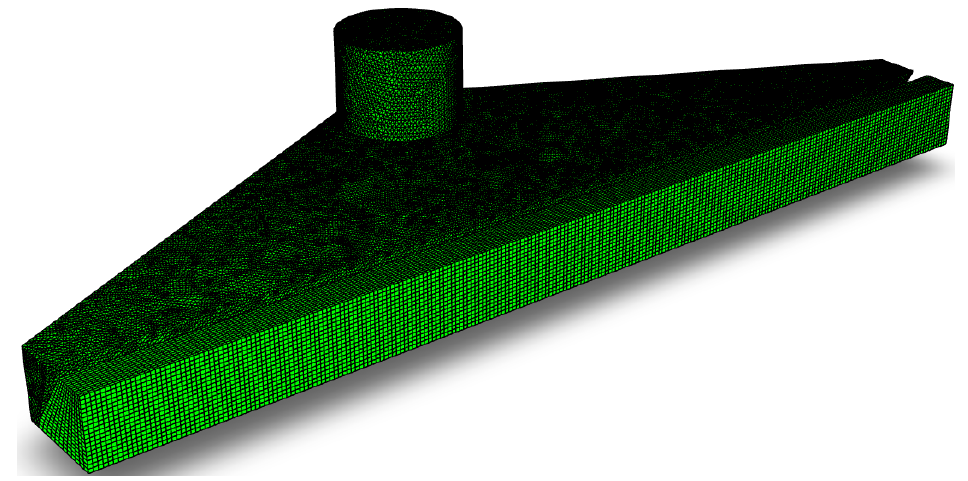
Figure 2. Simulation model grid structure.